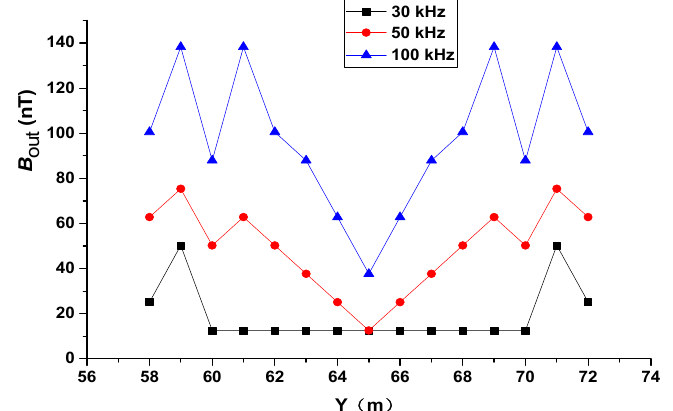
Figure 12. The secondary field intensity along the survey line above the #6 conductor with different emission frequencies.